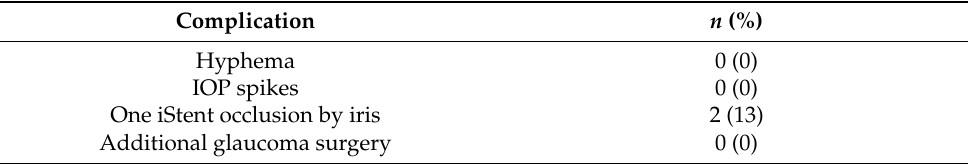
Table 2. Postoperative